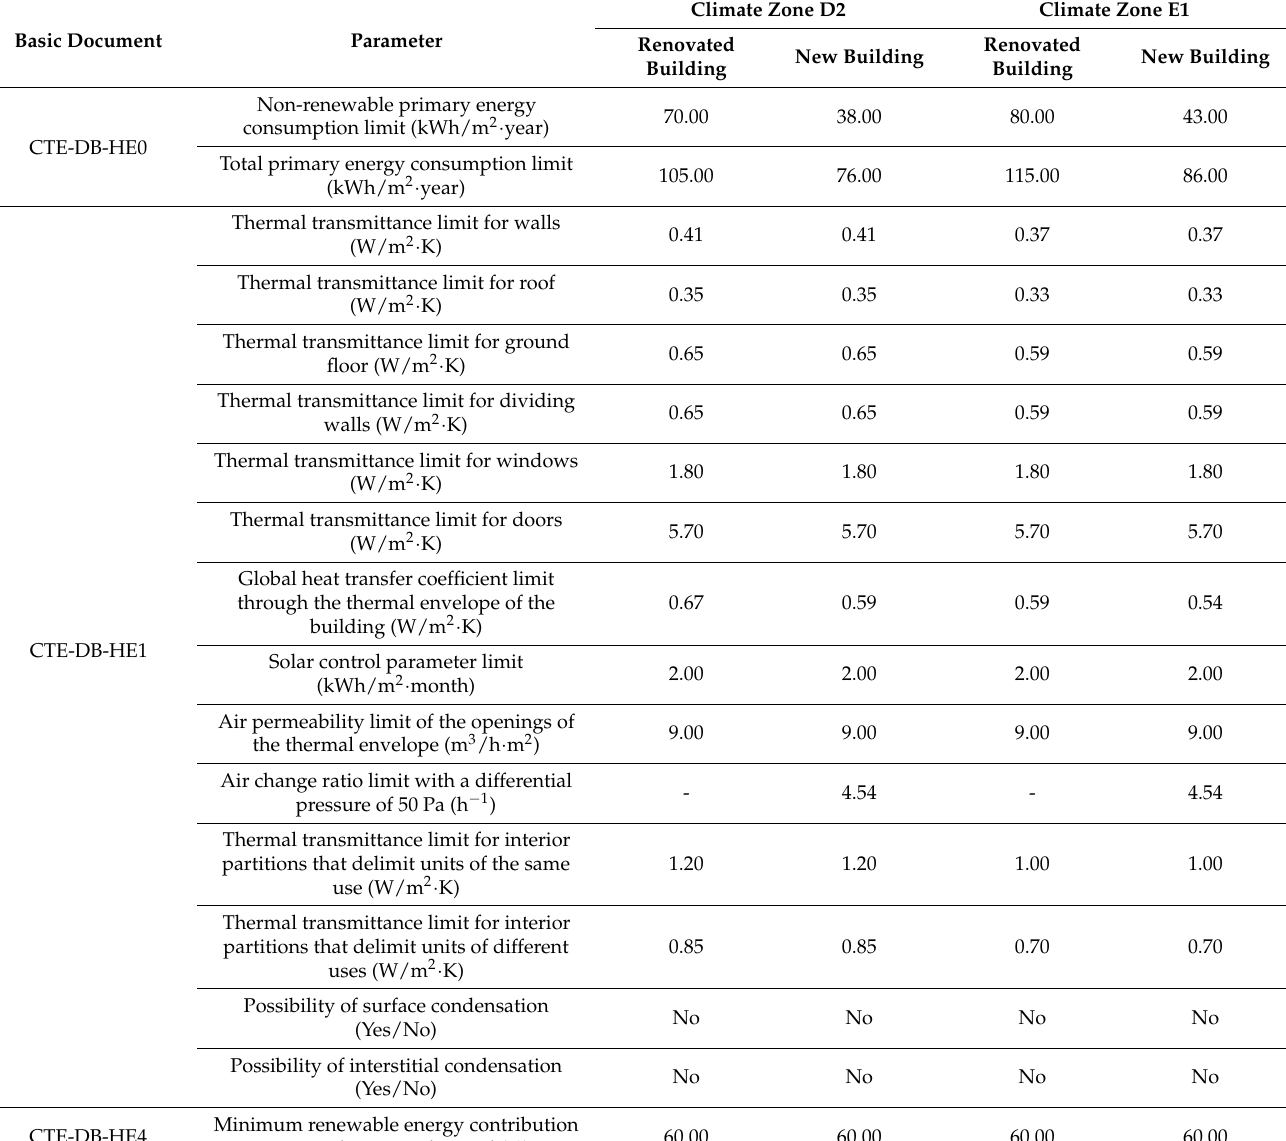
Table A1. Requirements to comply with the CTE-DB-HE [52] as a renovated building and as a new